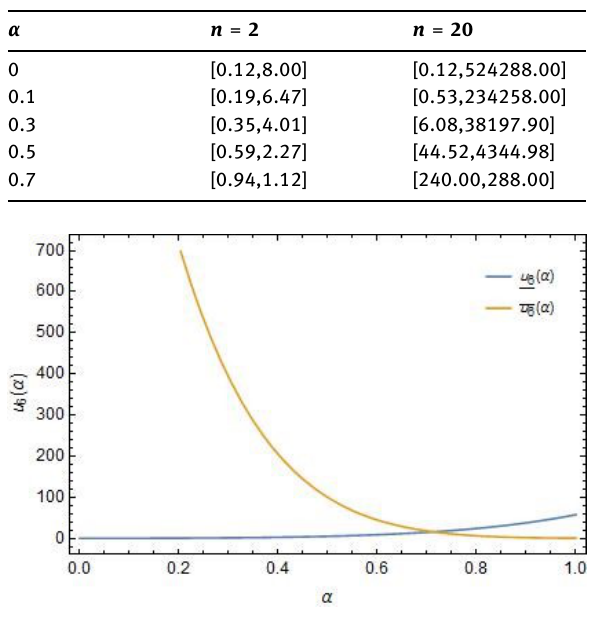
Table 6: Solution of u n ( α ) = ⌊ u n ( α ), ¯ u n ( α ) ⌋ of Example 5.2 for Type